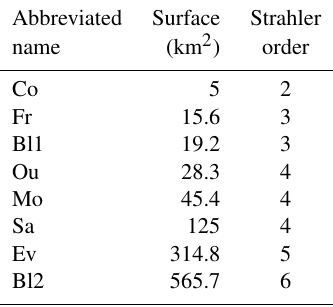
Table 1. Geomorphological characteristics of the 8 basins (DEM ALTI25).